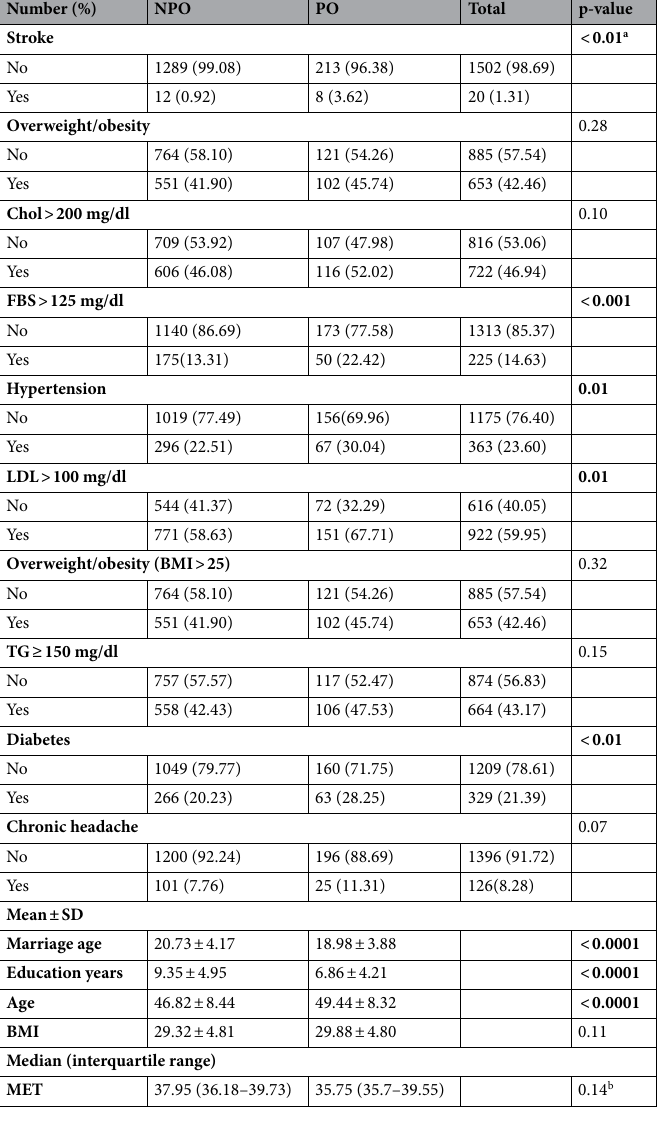
Table 1. Baseline characteristics of the study women population categorized by husband opiate smoking. Data are given as mean ± SD, absolute number n (percentage), or median (interquartile range). p-values for differences between categories were obtained using the t-test or Mann–Whitney test for continuous variables and using the χ 2 or Fisher Exact Test for categorical variables. Significant values are in bold. BMI body